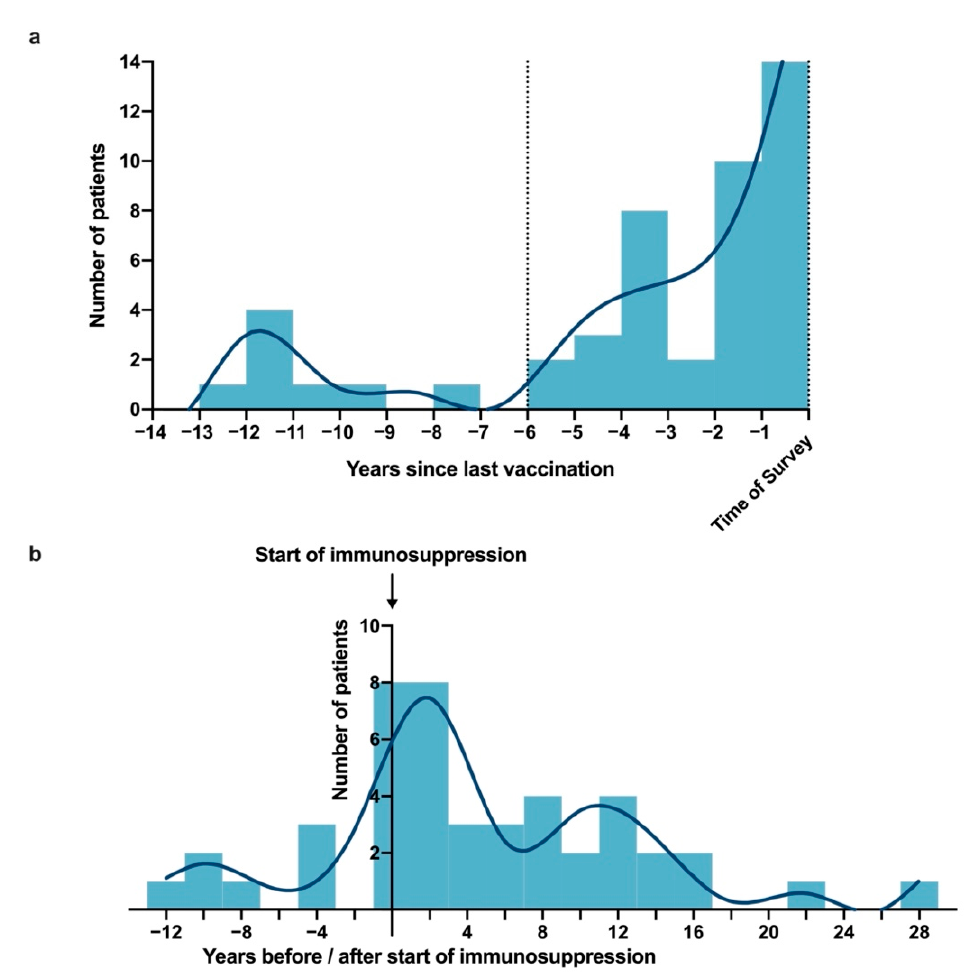
Figure 4. Years since last pneumococcal vaccination and years of pneumococcal vaccination in relation to immunosuppressive therapy. ( a ) Frequency distribution of years since patients’ last pneumococcal vaccinations. A bin width of one year was chosen. The dotted lines enclose all patients vaccinated in the last six years, which is the STIKO recommended time frame after which pneumococcal booster vaccinations may be considered [14]. Patients with a pneumococcal vaccination at some point according to vaccination certificate were categorized as vaccinated (n = 47). ( b ) Frequency distribution of years between the first pneumococcal vaccination and the start of the patient’s immunosuppressive therapy. Only the 45 PsO patients who received immunosuppressive therapy and pneumococcal vaccination at some point were considered in this